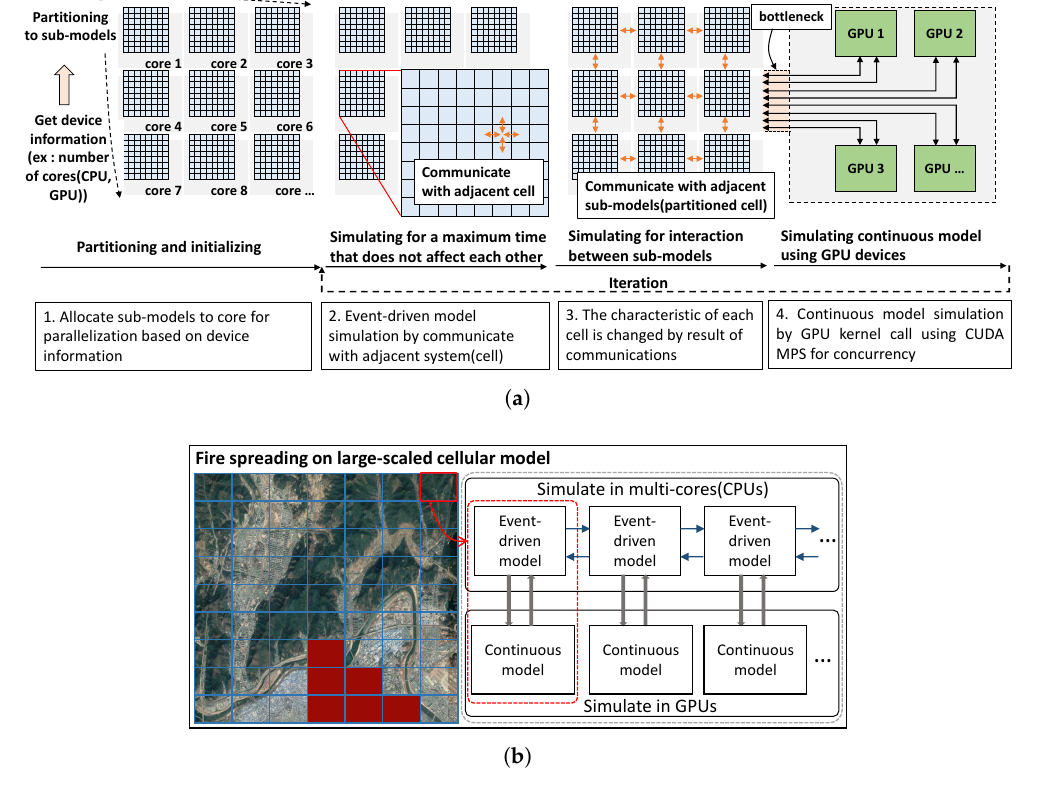
Figure 7. ( a ) Simulation flow in proposed heterogeneous architecture; ( b ) case study: fire-spreading on large-scale cellular model (base territory image is captured from